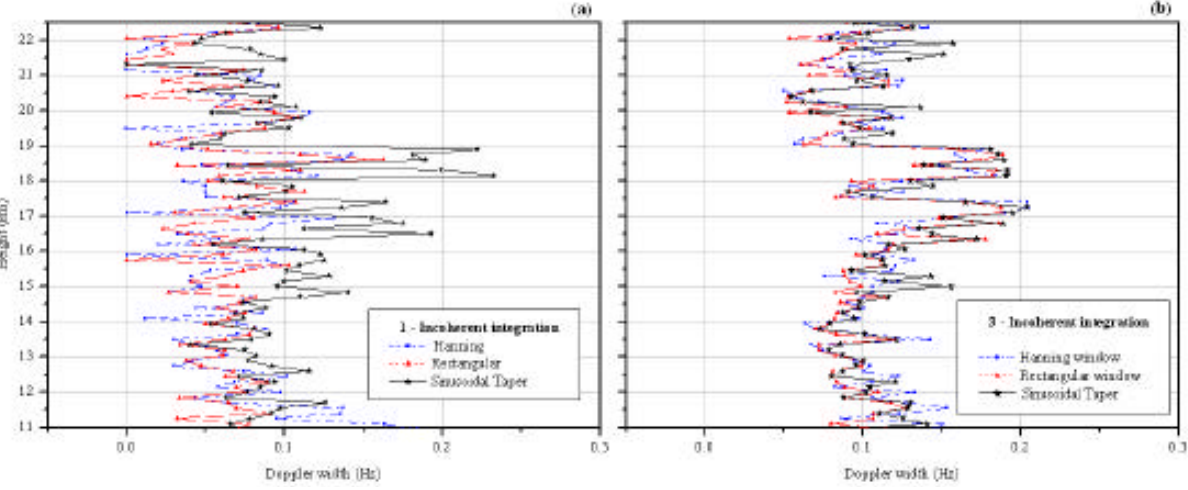
Figure -7 Fig. 7. Doppler width (half) estimated from power spectra obtained through Hanning, rectangular, and sinusoidal tapers for (a) one incoherent integration (b) three incoherent